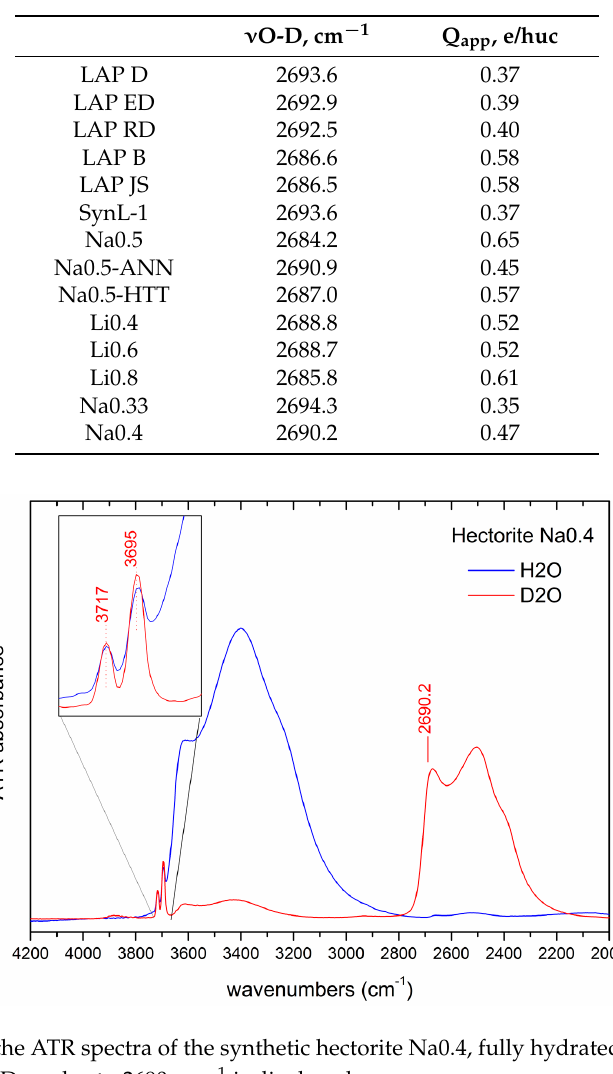
Table 3. Position of ν O-D stretch (cm − 1 , ± 0.2) per [31] and apparent layer charge (Q app , e/huc, ± 0.02). See text for details.